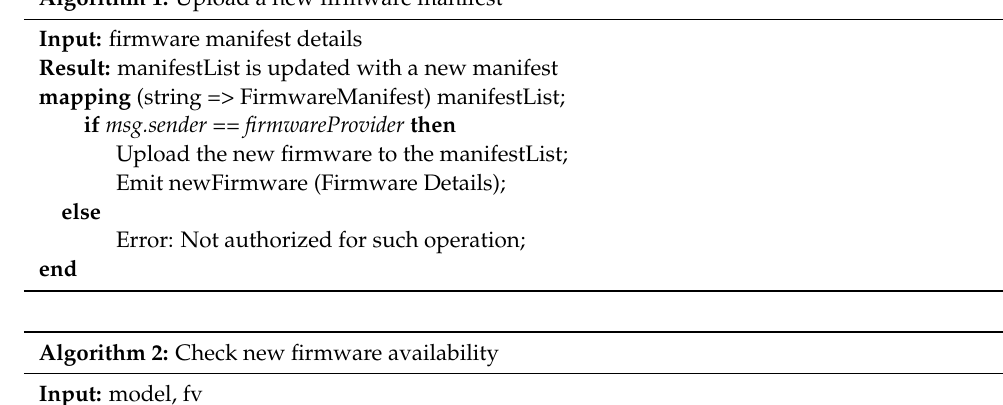
Algorithm 1: Upload a new firmware manifest